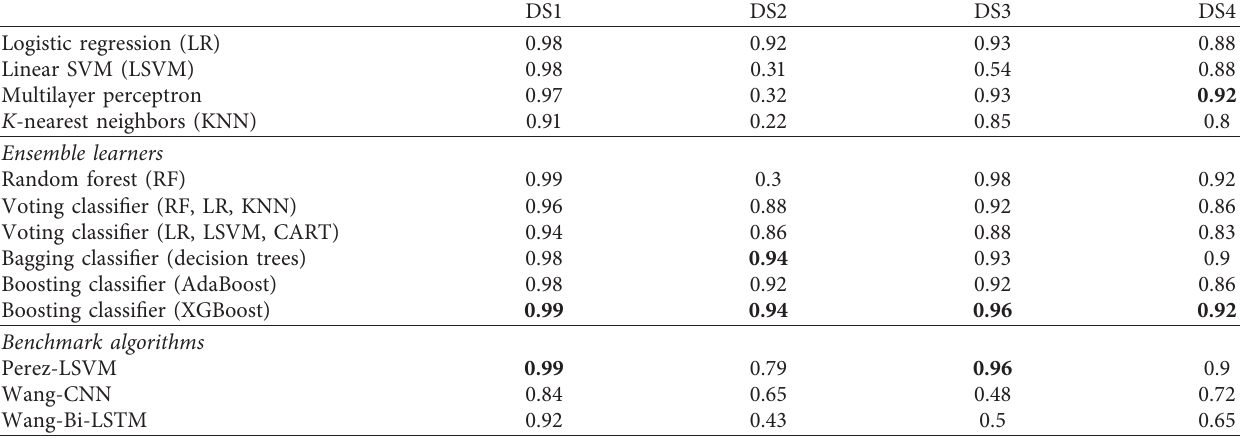
Figure 2: Average accuracy over all datasets. Table 3: Precision on the 4 datasets.